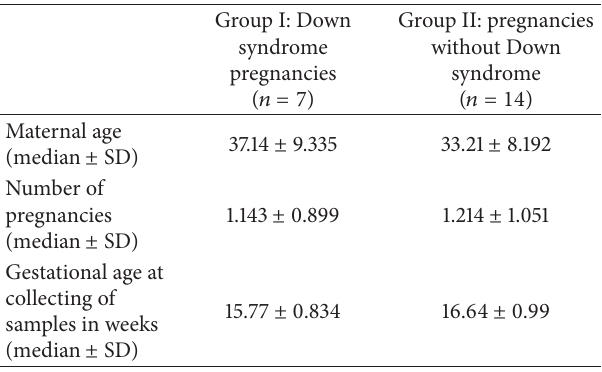
Table 1: Clinical characteristics of the